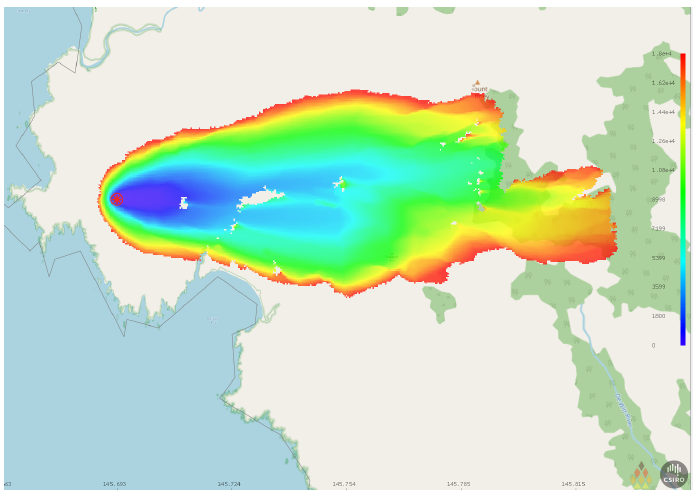
Figure 2. Visualization of an example fire simulation using Spark for a location in Tasmania,